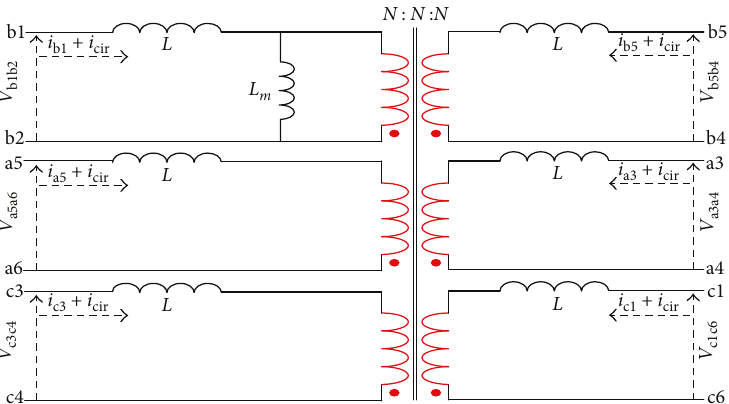
Figure 13: Equivalent circuit of the six-winding coupled